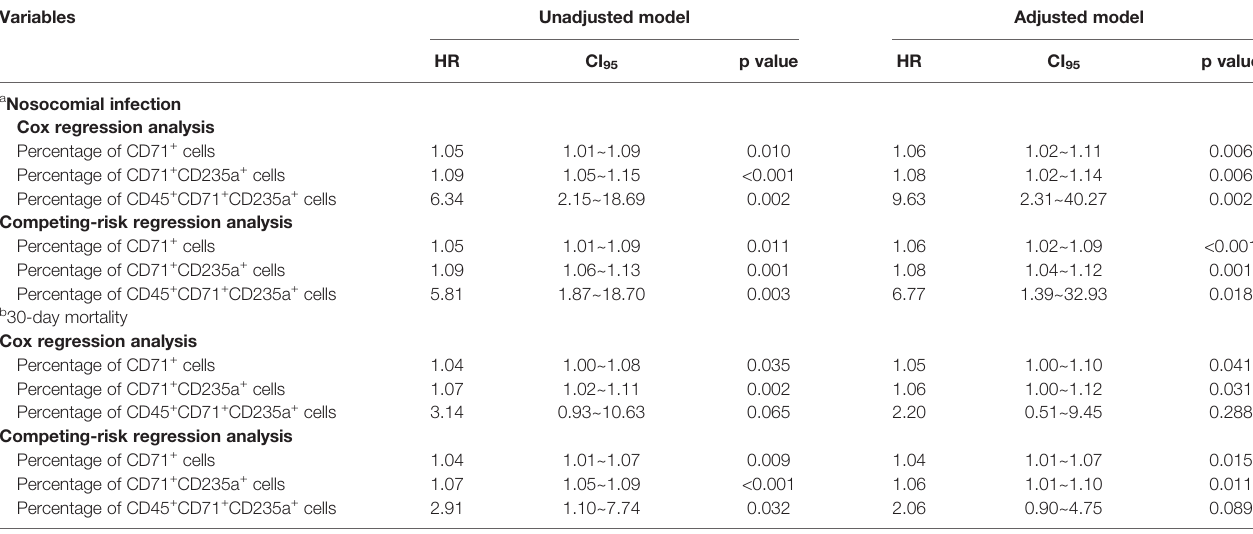
TABLE 2 | Cox regression analysis and competing-risk regression analysis of CD71+ cells and CECs for predicting nosocomial infection and mortality in septic patients. Variables Unadjusted model Adjusted model HR CI 95 p value HR CI 95 p